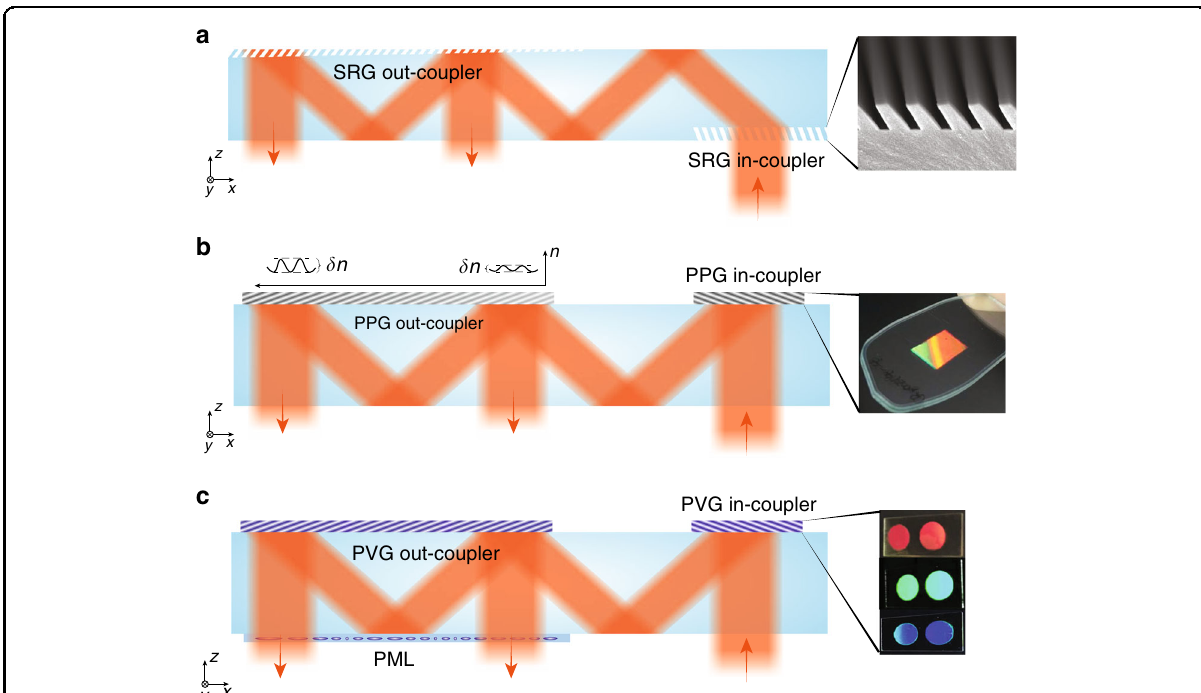
Fig. 12 Working principles of diffractive waveguide combiners. Schematics of waveguide combiners based on a SRGs, b PPGs and c PVGs. Reprinted from a ref. 85 with permission from OSA Publishing, b ref. 185 with permission from John Wiley and Sons and c ref. 189 with permission from OSA